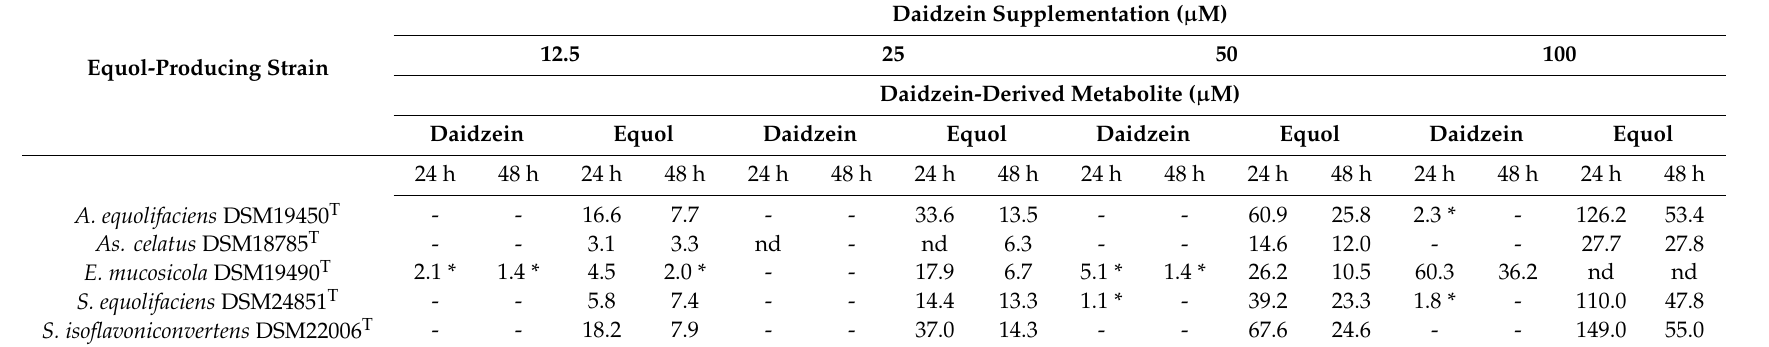
-, not detected; nd, not done; asterisks denote samples with a concentration of the compounds below the